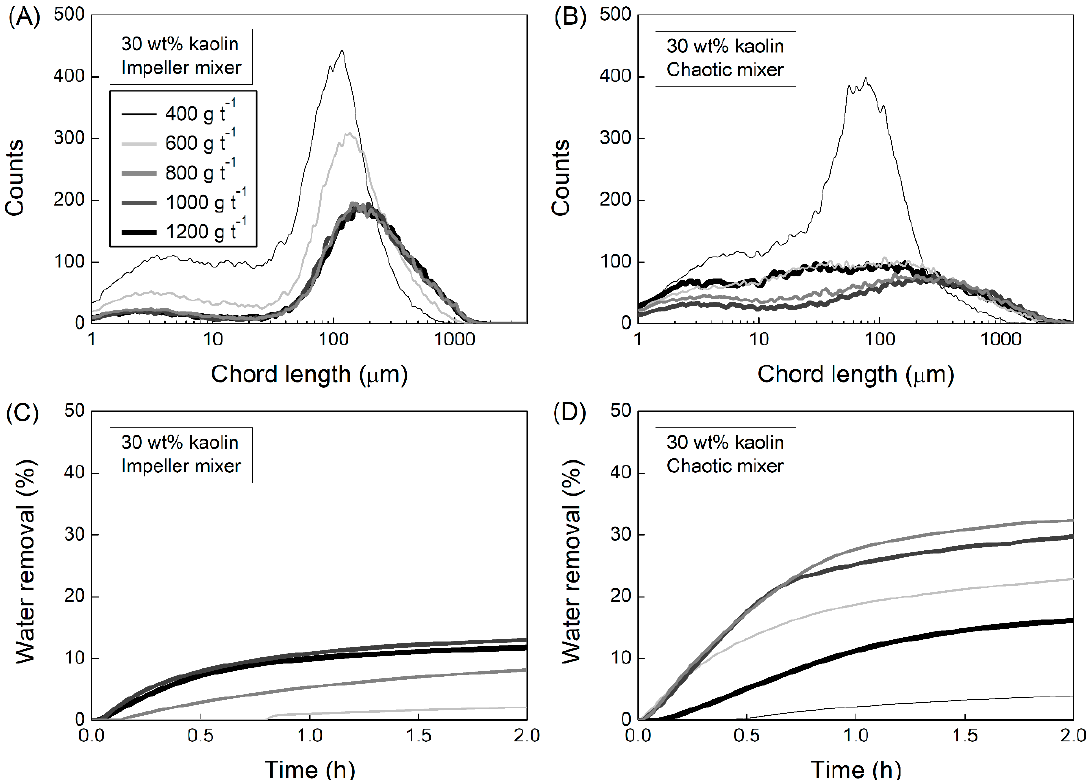
Figure 6. ( A , B ) Unweighted chord length distributions for 30 wt % kaolin as a function of Magnafloc ®